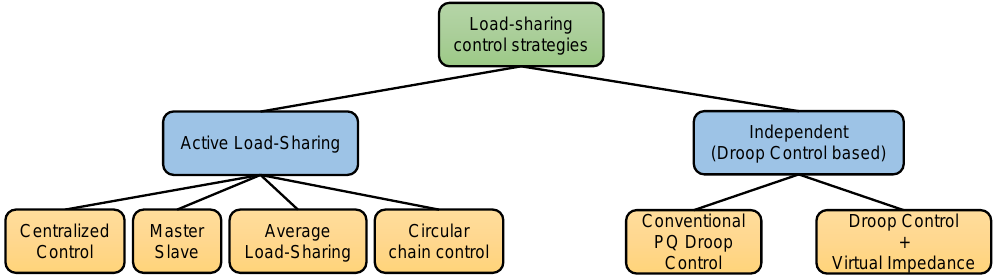
Figure 1. Main types of load-sharing control schemes used for paralleled connected UPS (adapted from